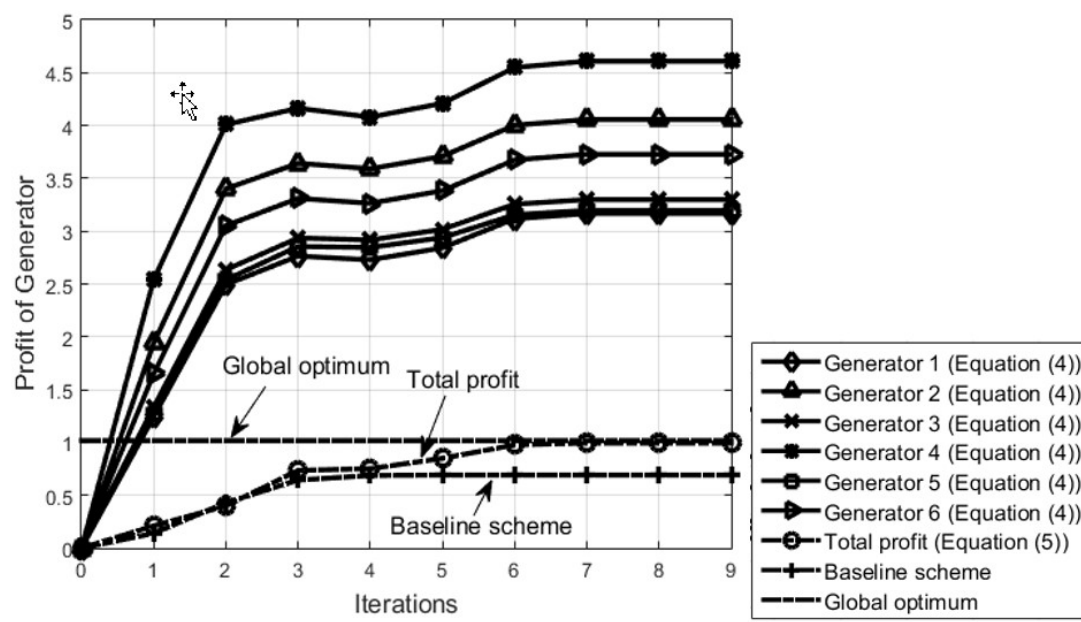
Figure 4. Generator profit versus